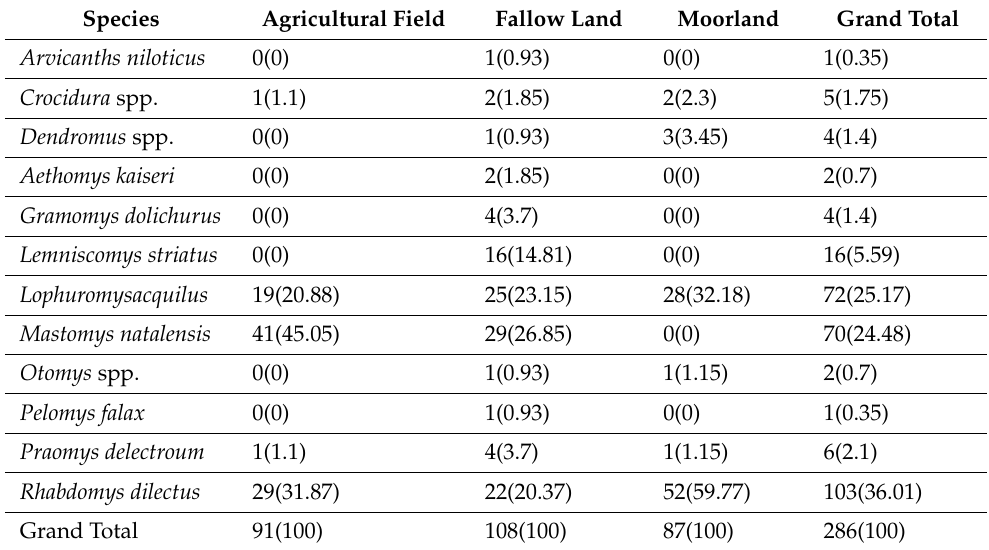
Table 1. Sample size and percentage % composition (number in parentheses) of rodent species across habitats. Species Agricultural Field Fallow Land Moorland Grand Total Arvicanths niloticus Crocidura